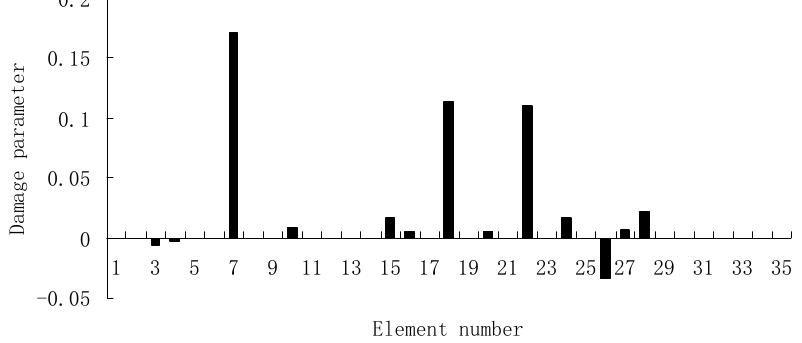
Figure 10. Damage evaluation result by the first computation of ESVT for case 2 (elements 7 and 18 had 15% and 20% stiffness reductions).